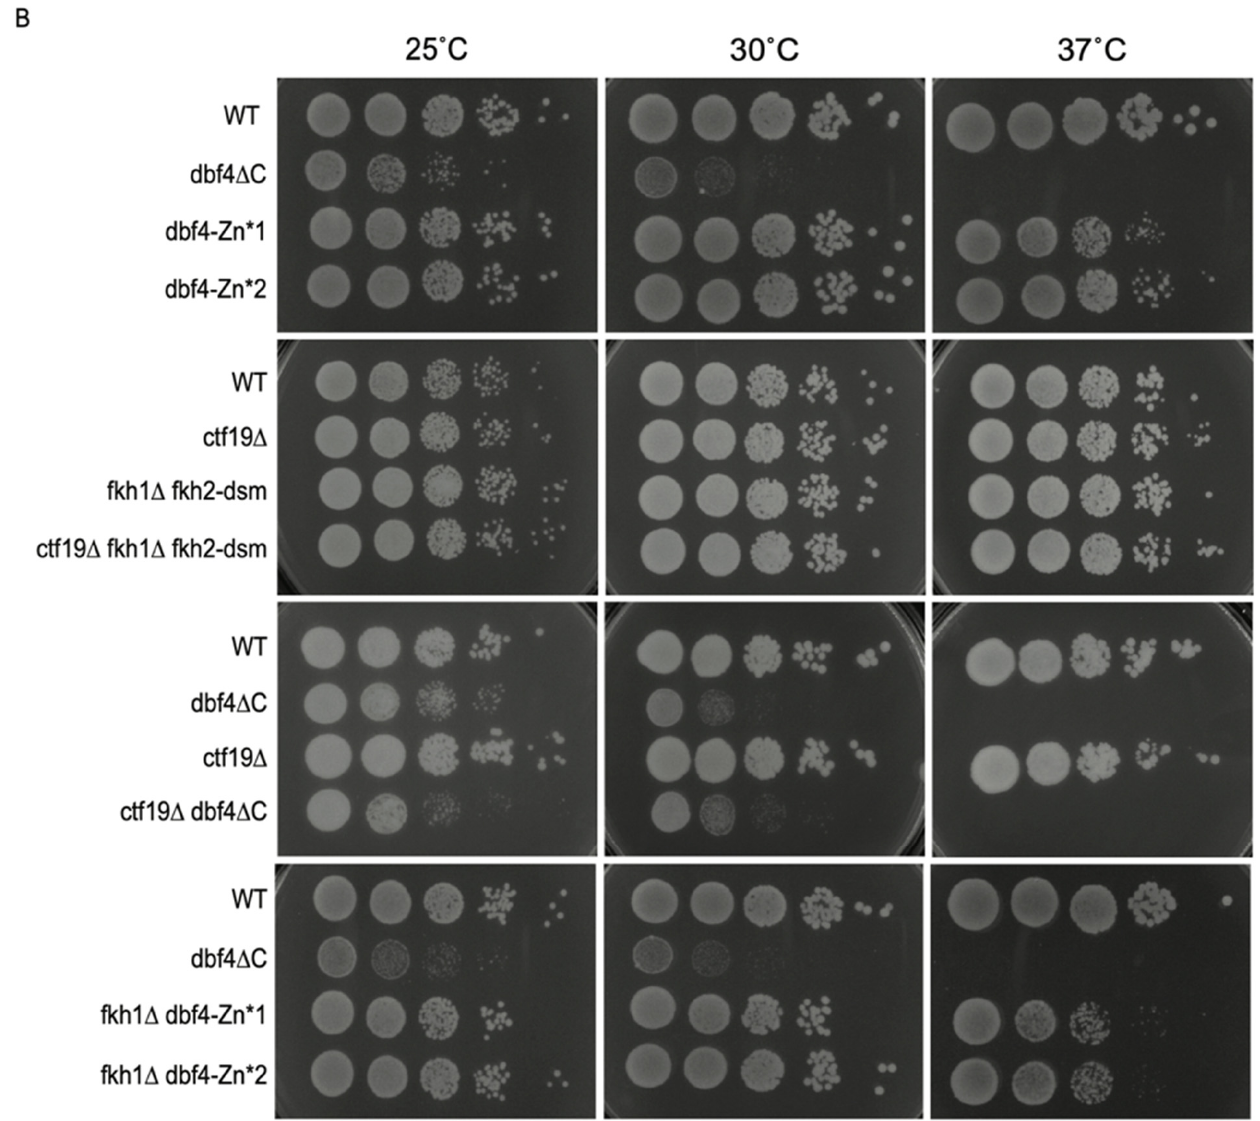
Figure 1. Dbf4 ∆ C is defective in essential Dbf4 function(s). ( A ) Schematic representation of Dbf4 protein domains with sequence detail of the Zn-finger domain; amino acid changes in the Zn* alleles are indicated in lower case, red font. ( B ) Strains CVy63 ( WT ), HYy176 ( dbf4 ∆ C), MPy74 ( dbf4-Zn*1 ), MPy76 ( dbf4-Zn*2 ), MPy86 ( dbf4-Zn*1 fkh1 ∆ ), MPy90 ( dbf4-Zn*2 fkh1 ∆ ), HYy210 ( cft19 ∆ ), HYy211 ( cft19 ∆ dbf4 ∆ C ), HYy207 ( cft19 ∆ fkh1 ∆ fkh2-dsm ), and HYy218 ( fkh1 ∆ fkh2-dsm ) were grown to mid-log phase, diluted, and plated onto rich media, then incubated at the indicated temperatures and imaged after 2–3 days.